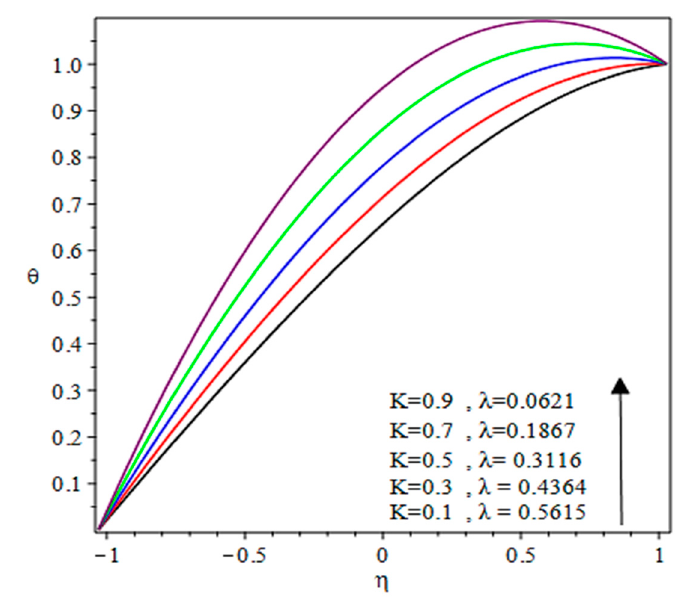
K on the temperature distribution at